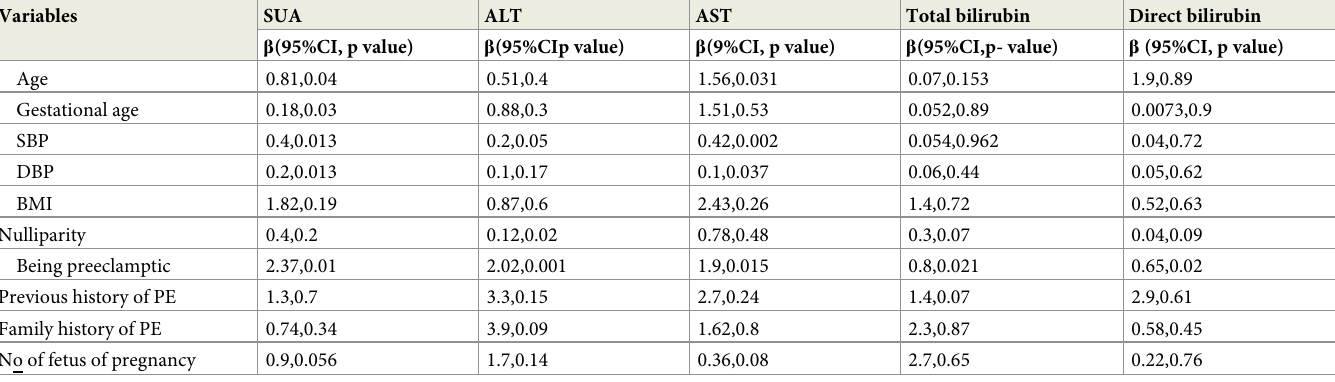
Table 3. Multiple linear regression analysis of SUA, ALT, AST, and bilirubin levels with different predictor variables of preeclamptic women, University of Gondar Comprehensive Specialized Hospital, Northwest Ethiopia, 2020.